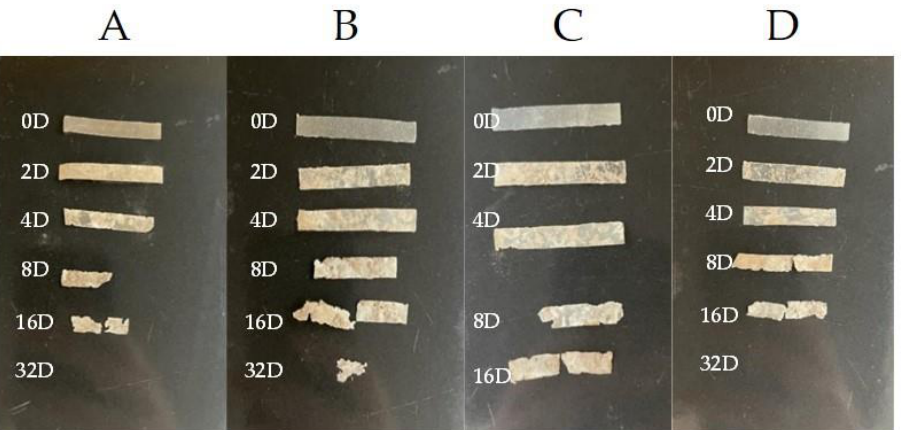
Figure 2. Physical shapes of the samples during incubation, observed at different times: 0, 2, 4, 8, 16, and 32 days: ( A ) pure PHB, ( B ) PHB + 3% eucalyptol, ( C ) PHB + 3% limonene, and ( D ) PHB + 3% thymol.